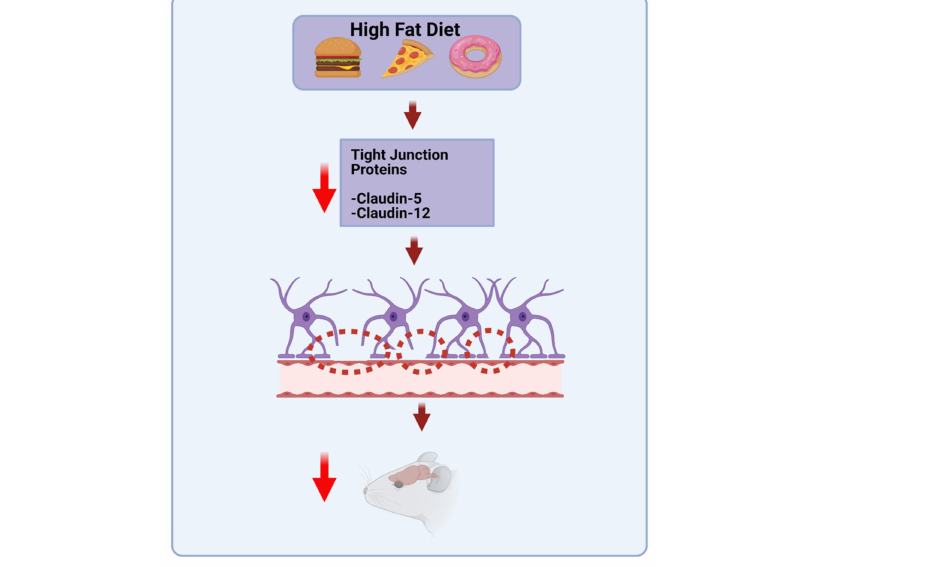
Figure 3. HFD diet can induce inflammation. Chronic HFD consumption can lead to leakage in the intestinal barrier, leading to elevated serum levels of LPS. Elevated LPS may be a triggering factor for the development of insulin resistance, obesity, and